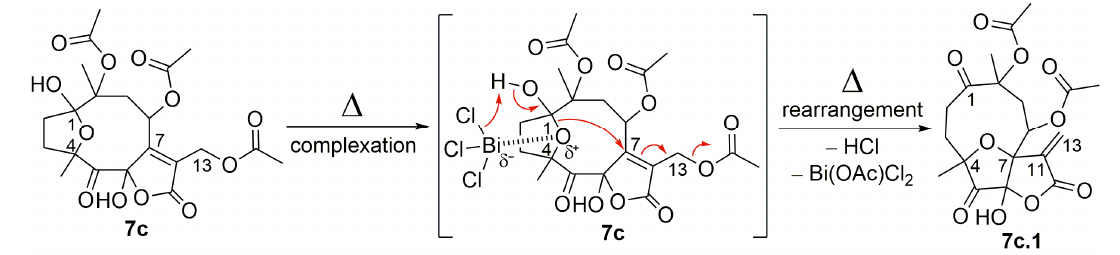
9 of 23 Figure 10. Proposed mechanism for the formation of SL semisynthetic derivative 7c (red arrows illustrate the arrow-pushing mechanism). As illustrated in Figures 7 and 11, the oxidized hirsutinolide analog ( 7c ) was further treated with BiCl 3 in reflux, aiming to prepare a vernomargolide derivative. Unexpectedly, a new 1,5-oxo-4(7)-epoxy-6-hydroxy- γ -butyrolactone derivative bearing a macrocyclic hydrocarbon ring was obtained (13.2%). Its structure was assigned as 8,10- diacetoxy-4(7)-epoxy-6-hydroxy-1,5-oxo-germacr-11(13)-en-6(12)-olide ( 7c.1 ) based on its spectrometric data. The proposed mechanism pathway to form 7c.1 (Figure 11) involved a tandem reaction process including hydrolysis of the C-1 hemiacetal ring after bismuth complexation under reflux and a nucleophilic attack at C-7, causing the allylic elimination of Bi(OAc)Cl 2 . Although an oxidized decaline core was aimed to be the main product